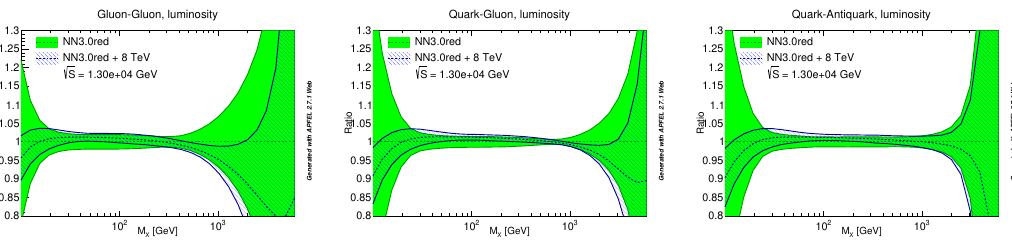
Figure 18 . Impact of the inclusion of p Z at LHC 13